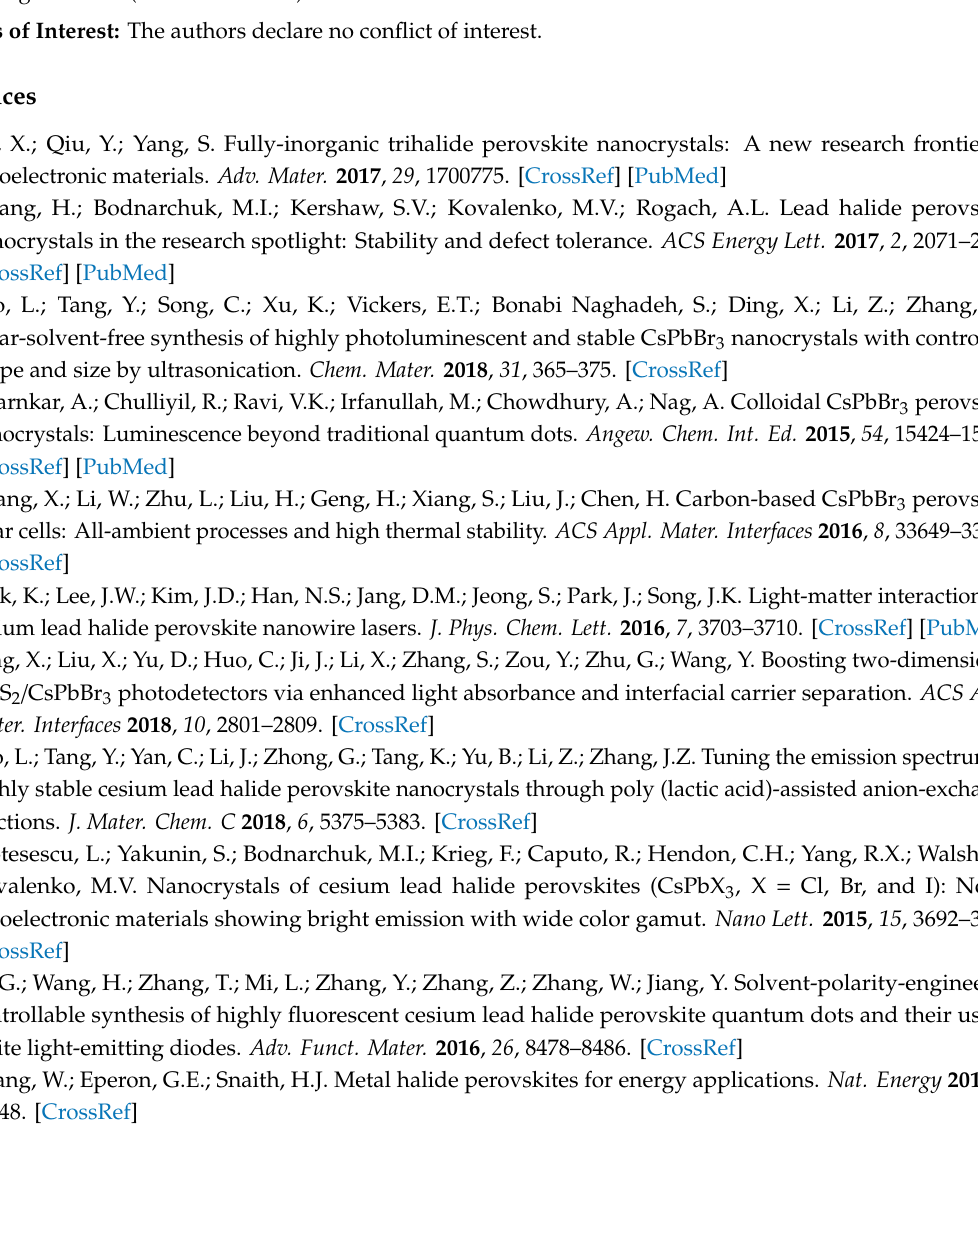
Figure S1a,b. The statistics of width and length of the samples when KCl was added. Figure S1c,d. The statistics of width and length of the samples when KBr was added. Figure S1e,f. The statistics of width and length of the samples when KI was added. Figure S2: Element mapping of the samples prepared by Cs 4 PbBr 6 transformation with KCl aqueous solution, Figure S3: XRD patterns of the samples prepared by Cs 4 PbBr 6 transformation with (a) KBr and (b) KI aqueous solution, Figure S4: The PL spectra of the samples that were synthesized by Cs 4 PbBr 6 transformation with di ff erent halide solutions (a) ZnCl 2 , (b) ZnI 2 , (c) NaCl, and (d) NaI, Figure S5. The color change of the samples that were synthesized by the Cs 4 PbBr 6 transformation with di ff erent concentrations of (a) ZnCl 2 and (b) ZnI 2 aqueous solution. Table S1. The luminous e ffi ciency of di ff erent types of perovskite light